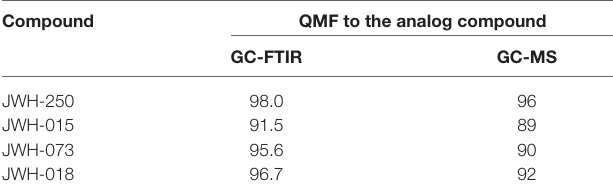
TABLE 3 | QMF for the compounds identified in a seized